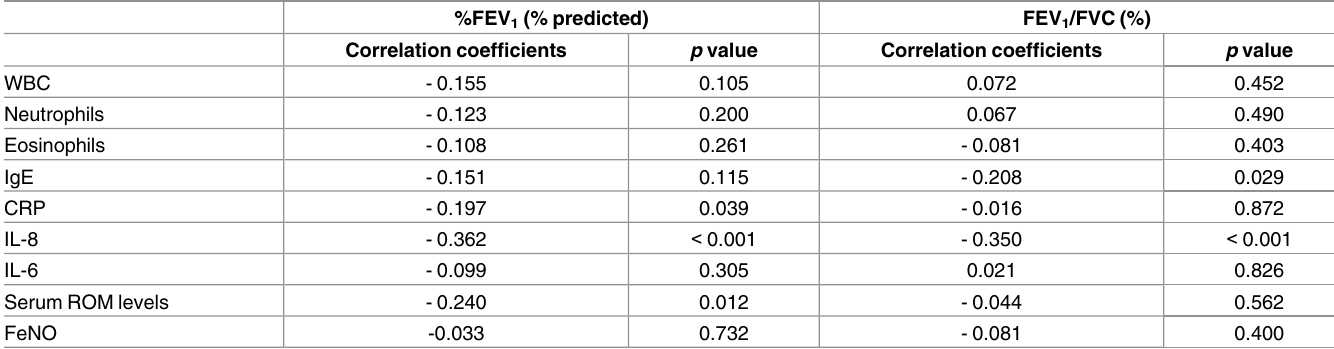
Table 3. Correlation Between Pulmonary Function Test Results and Biomarkers and Serum ROM